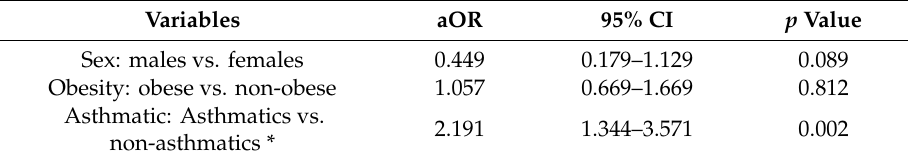
Table 4. Multivariate logistic regression analysis of factors determining high ghrelin values.